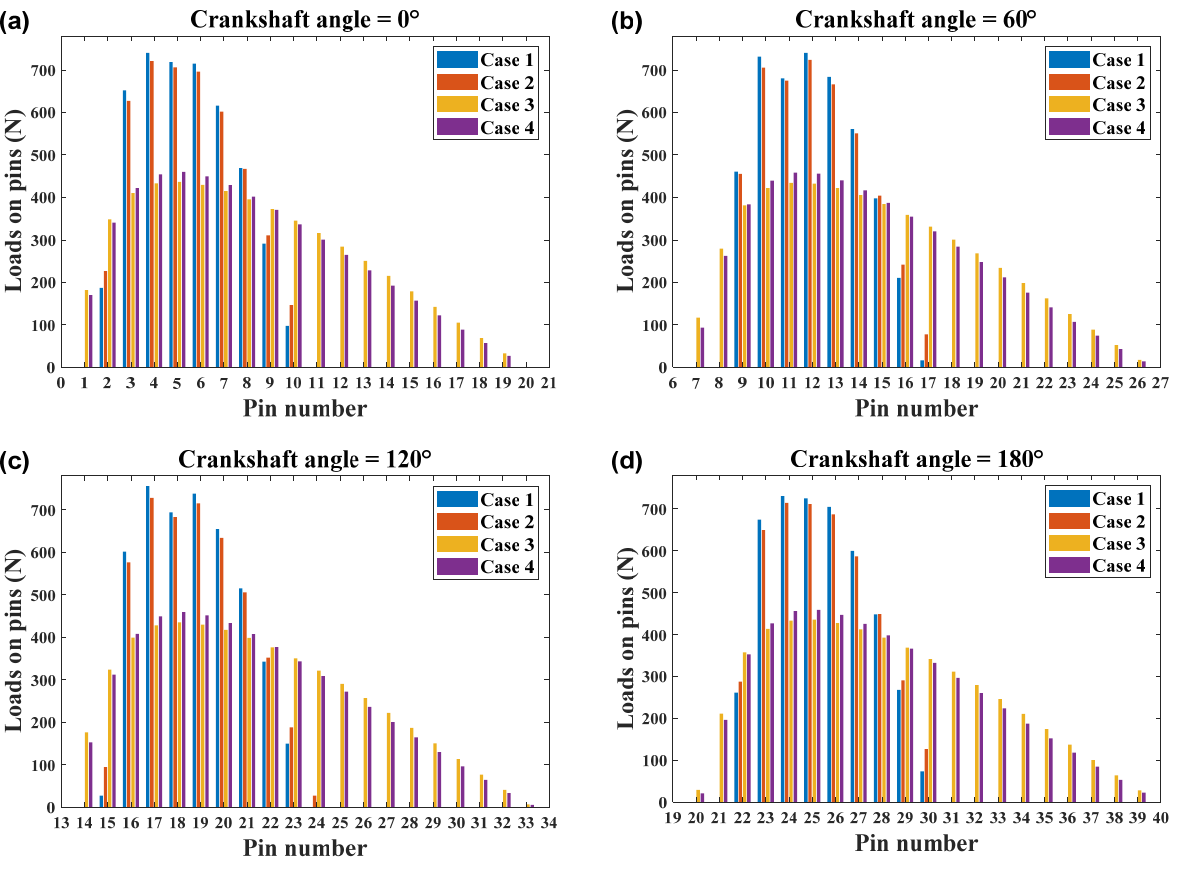
Figure 8. Comparison of the loads distributed among pins and pin-grooves at ( a ) 0 ◦ , ( b ) 60 ◦ , ( c ) 120 ◦ , and ( d ) 180 ◦ crankshaft angles for four cases.